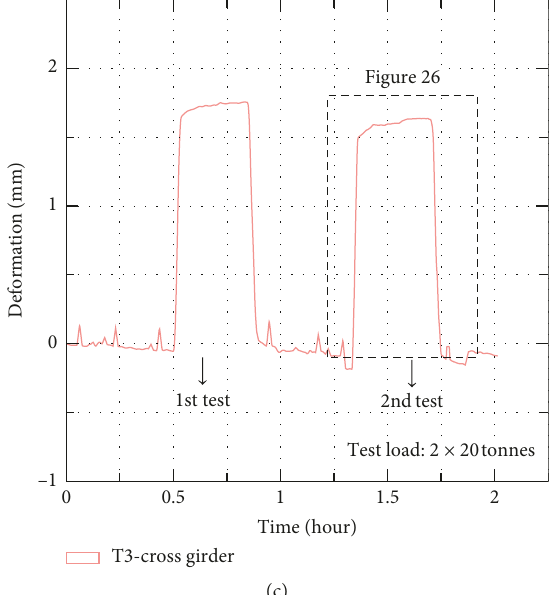
Figure 23: Graphs of cross girder (see sensor T3 in Figure 20) deflections (a) before strengthening (static load test with two load cases—heavy vehicles), (b) during prestressing, and (c) after strengthening (static load test with exact the same loading like before